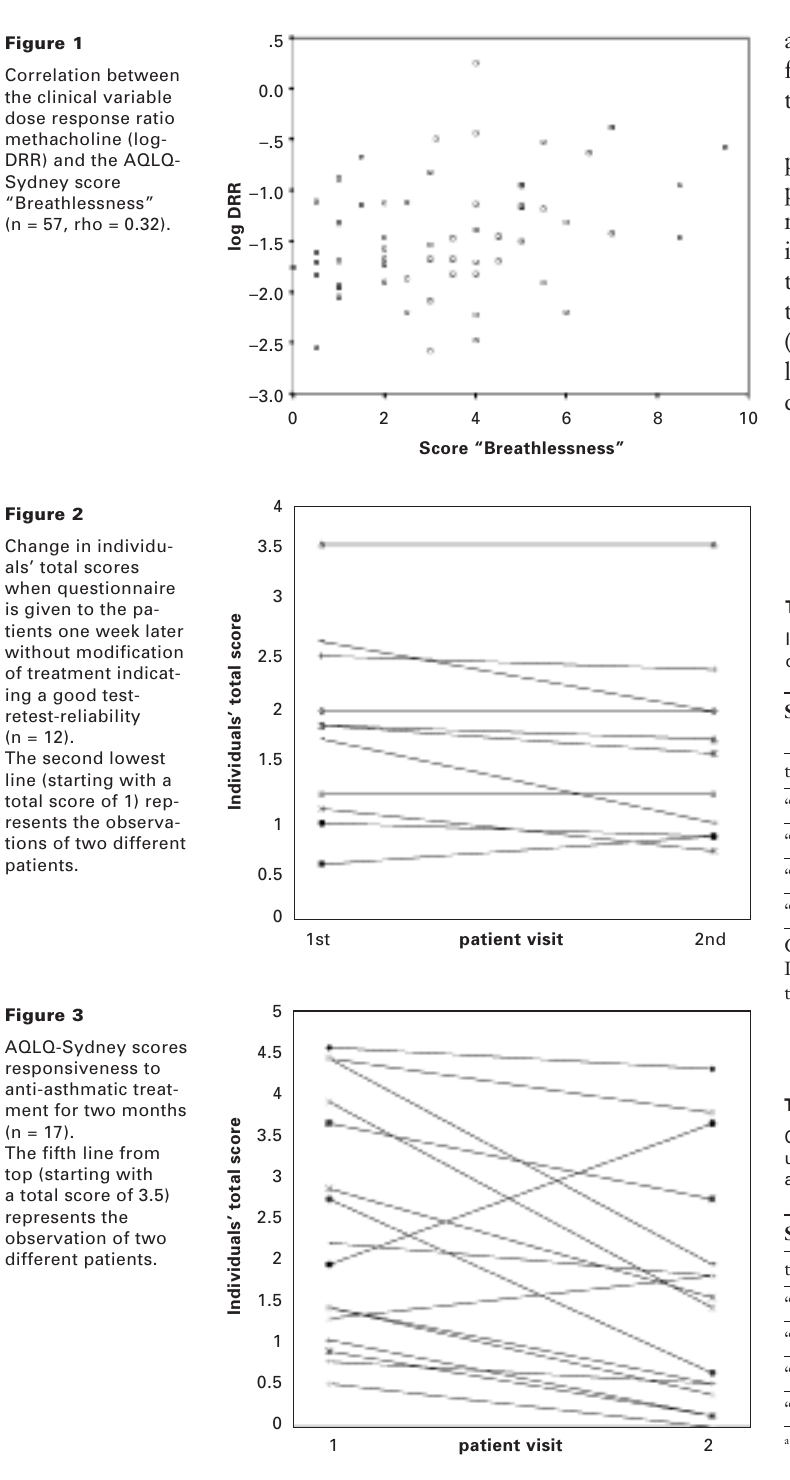
Change of the questionnaire scores in asthmatic patients under treatment with combined inhaled steroids and long acting bronchodilators for two months (n = 17) a